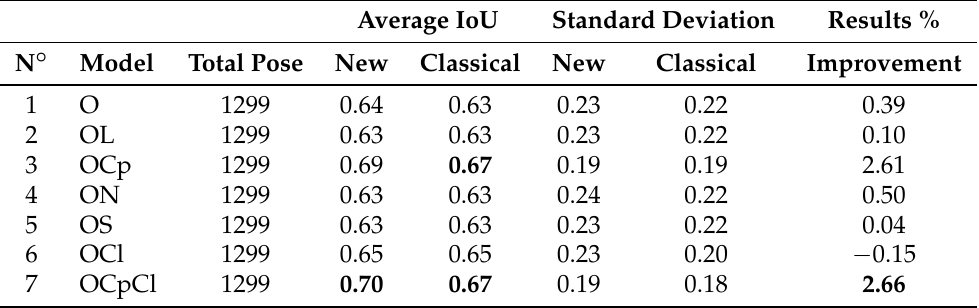
Table 4. Summary of model and method comparison. This table shows the results for each prediction model and two skeletonization methods, new [35] and classical (using the Matlab bwmorph function). The results column indicates the percentage value of the improvement using the new skeleton with respect to the classic skeletonization.